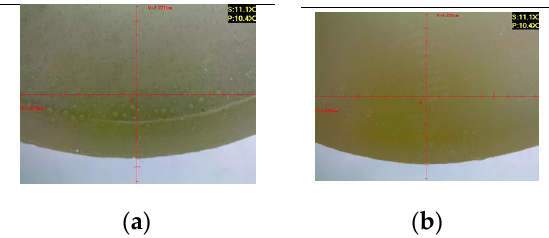
Figure 12. Reference samples: ( a ) Epidian 53 / Z-1; ( b ) Epidian 53 / Z-1 / CaCO 3 .